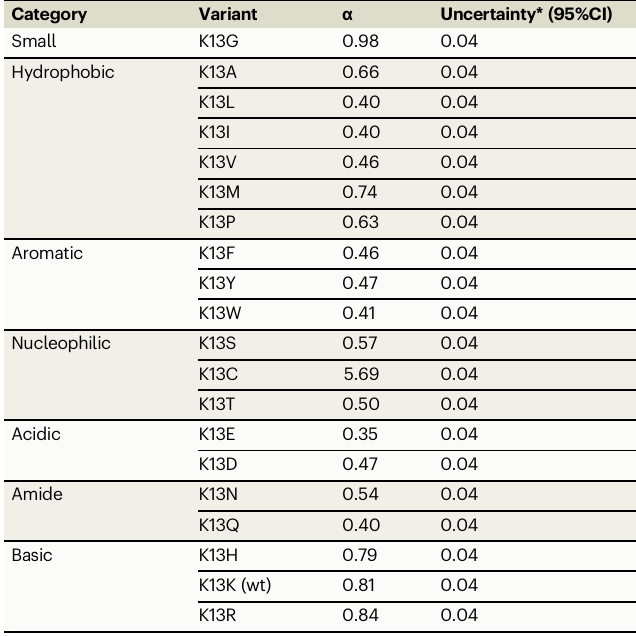
Table 1 | Alpha values of 20 GB3